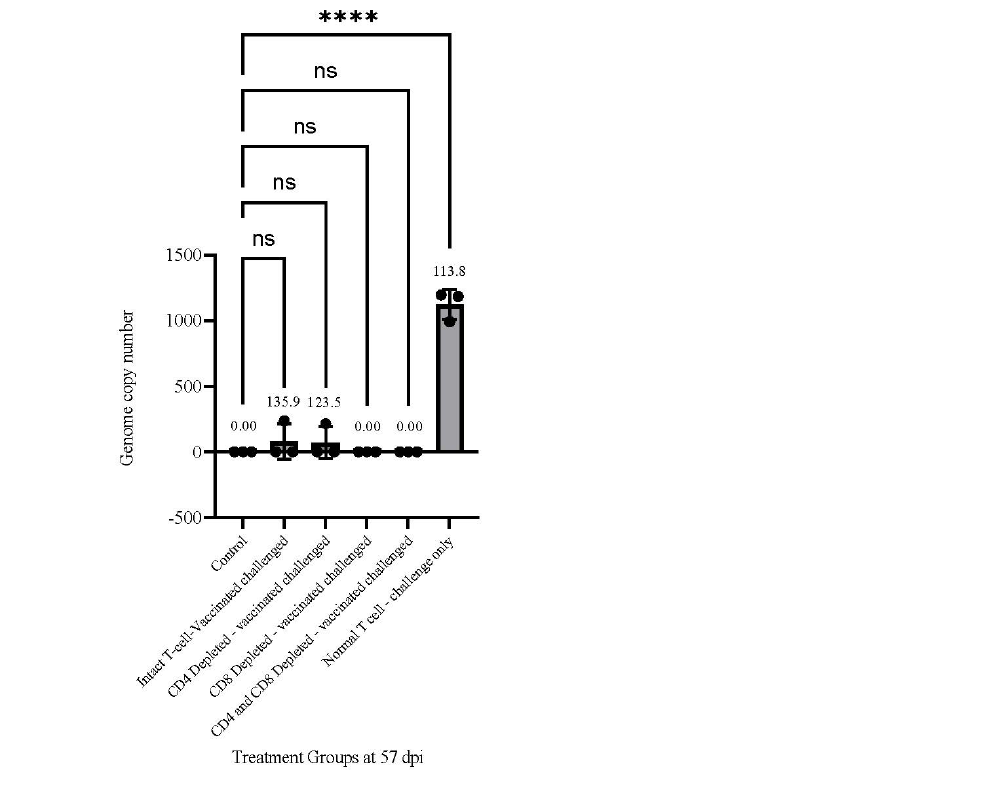
Figure 5. Viral genome copy number in the skin of infected birds at termination (57 dpi). DNA samples of the skin tissues from three individual birds from each group at 57 dpi were used for the determination of the viral genome copy number. The high genome copy number of MDV in the skin of the non-vaccinated challenged birds supports the result of immunohistochemical analysis. A Dunnett’s multiple comparison test (one-way ANOVA) was run between the control group (unvaccinated and unchallenged animals) and every other trial group at 57 dpi (termination). The normal T Cell, challenge-only group showed a significant difference from the control group (**** p value of < 0.0001, ns: no